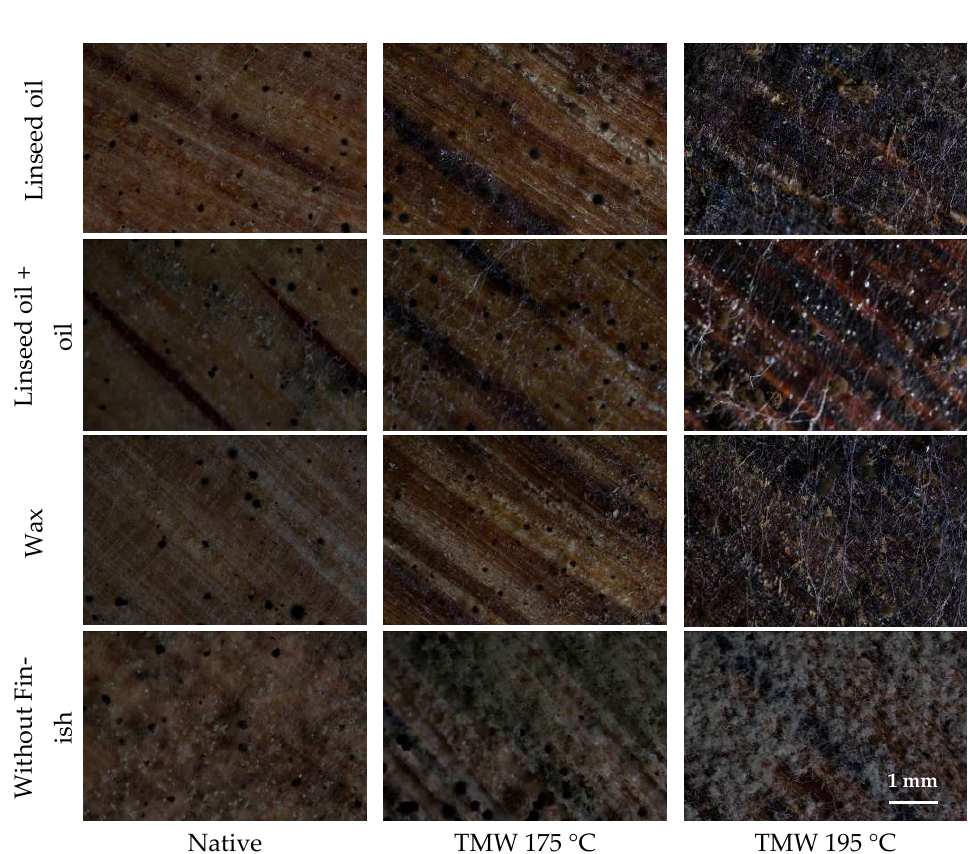
Figure 11. Resistance to molds after incubation for 21 days: surface finish with linseed oil, linseed oil + oil, wax and surface without finish.